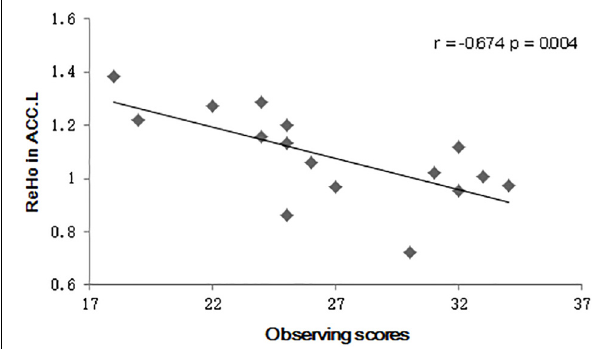
FIGURE 1 | Scatter plot diagrams. The plots and fitted lines indicate the inverse correlations between the observed scores and the regional homogeneity (ReHo) values in the left anterior cingulate cortex (ACC) in the Mindfulness-Based Stress Reduction (MBSR) group.